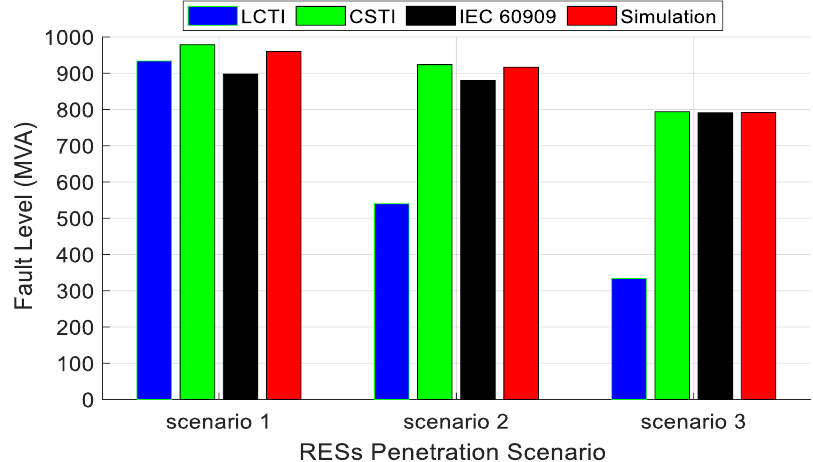
Figure 5. Bus five fault level in different penetration scenarios.